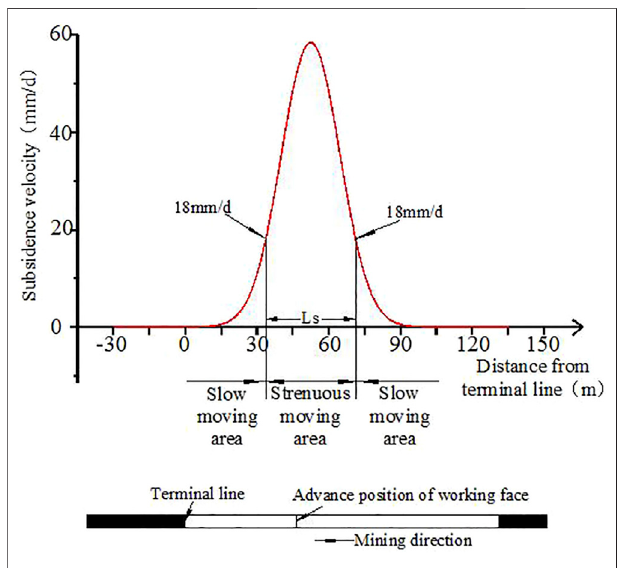
FIGURE 5 | Zoning map of surface strenuous moving.